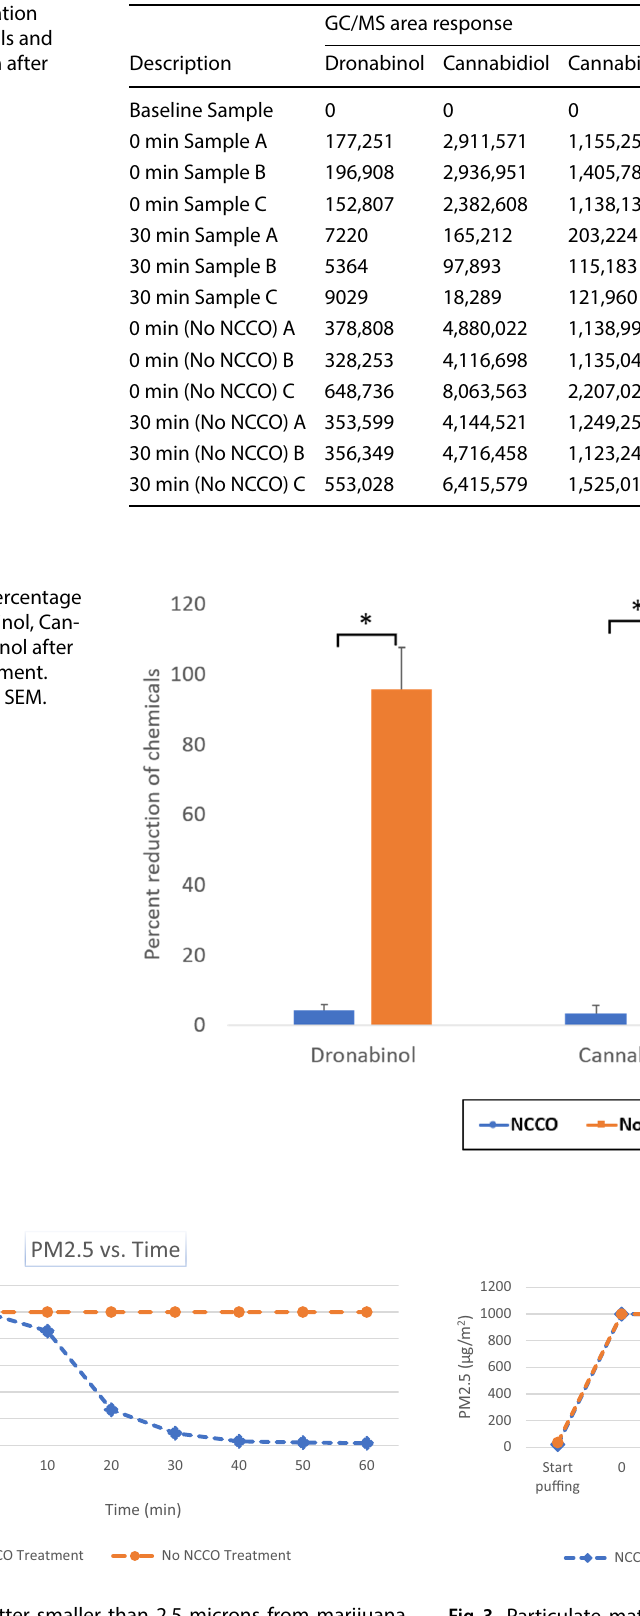
Fig. 3 Particulate matter smaller than 10 microns from marijuana